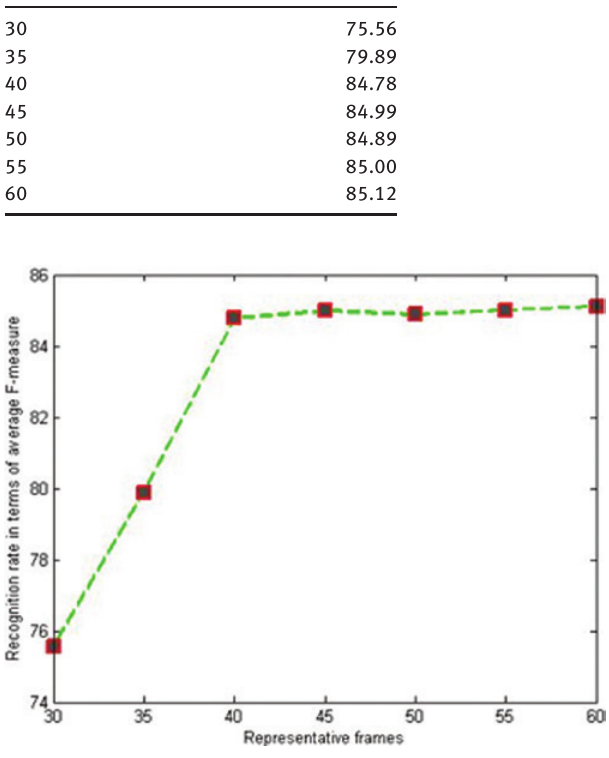
Table 5: Average F-measure Obtained by the Proposed Method for Different Numbers of Representative (Key) Frames. No. of